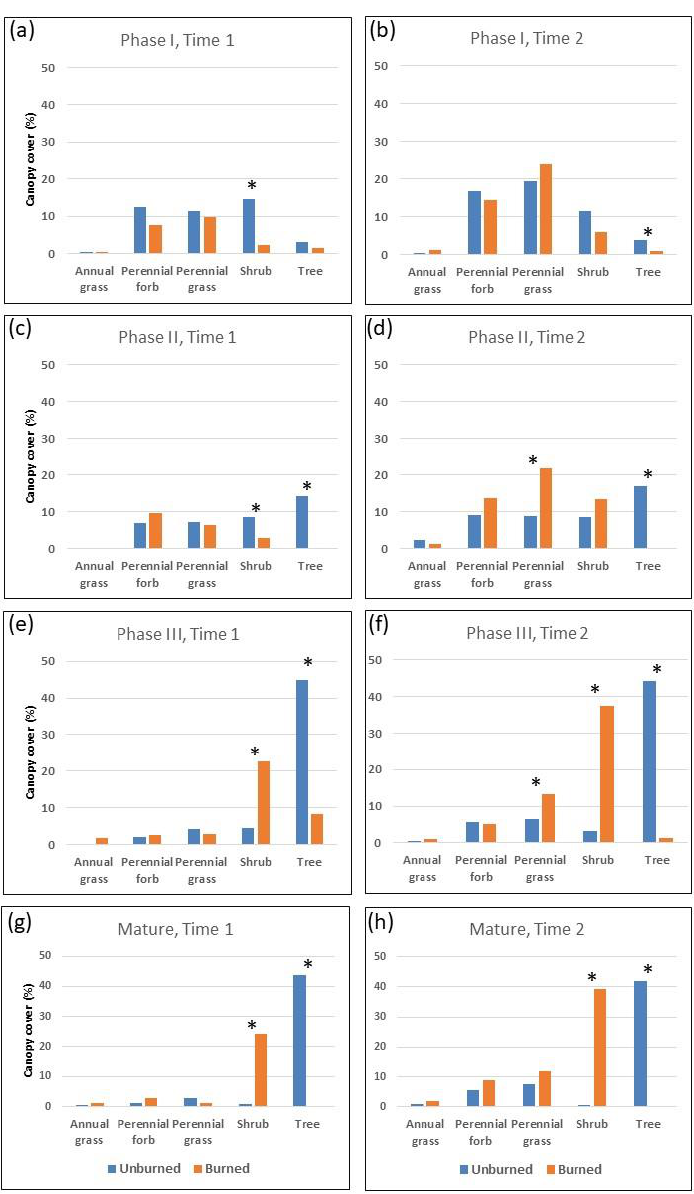
Figure 6. Comparison of canopy cover of functional plant groups between burned and unburned plots by woodland development phase and sampling period. Significant differences ( p < 0.05) in cover between burned and unburned plots are marked with a star (*).